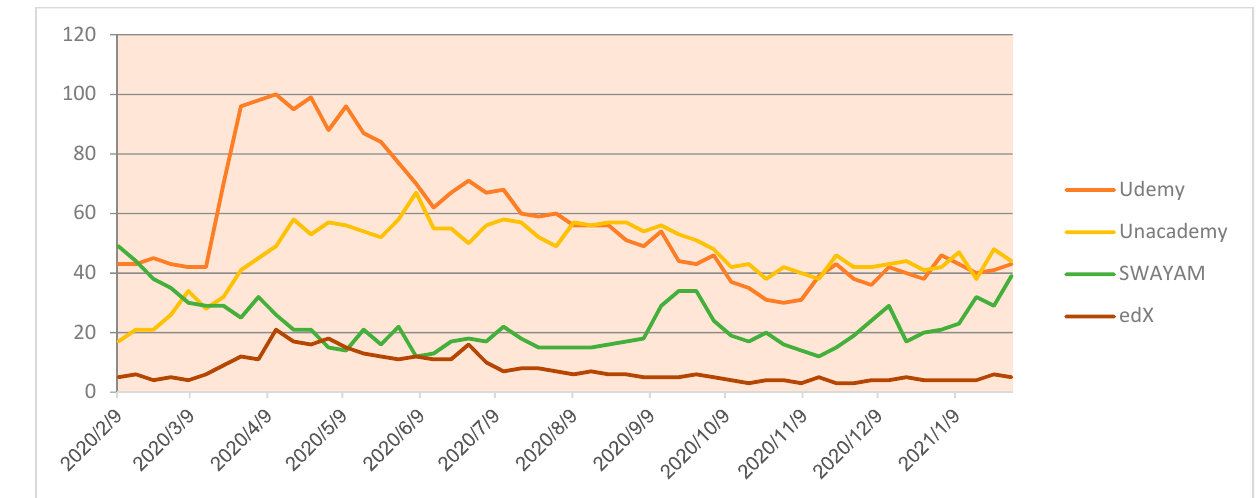
Figure 5. UG and PG course provider.